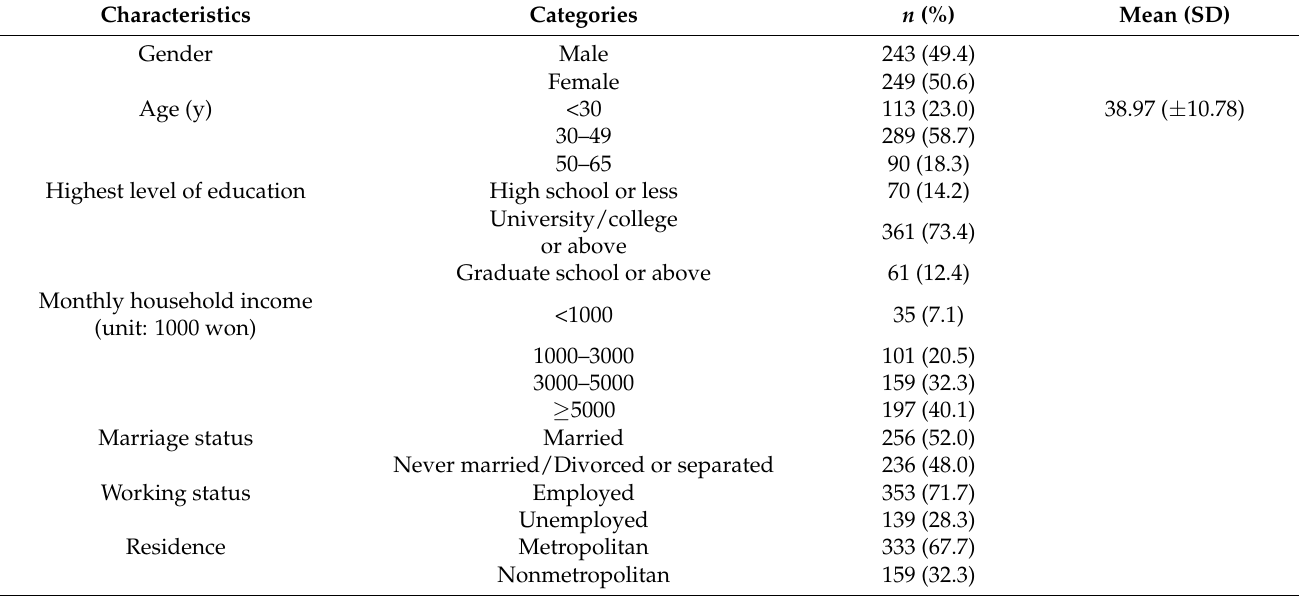
Table 1. General characteristics of respondents in the Korean version of the Environmental Health Engagement Profile scale ( n =